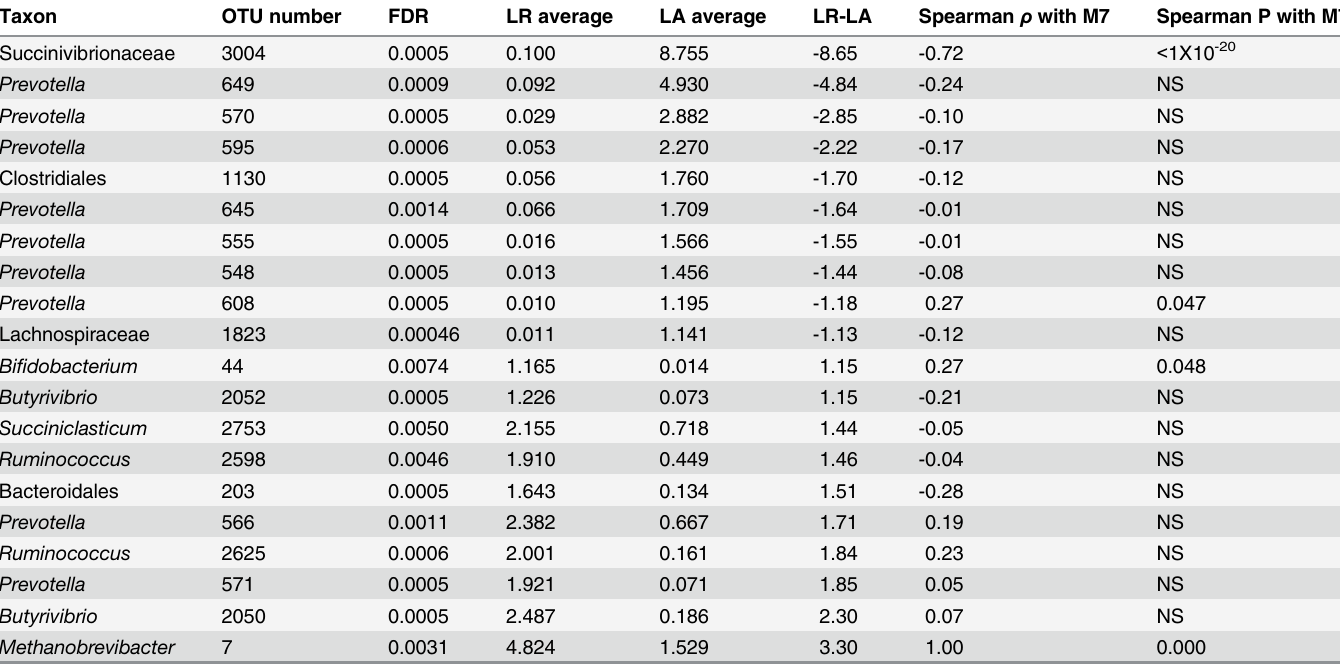
Table 3. Spearman correlation analysis between OTU M7and OTUs showing the largest (top 20) changes in relative abundance between rumen liq- uid of group R and group A.